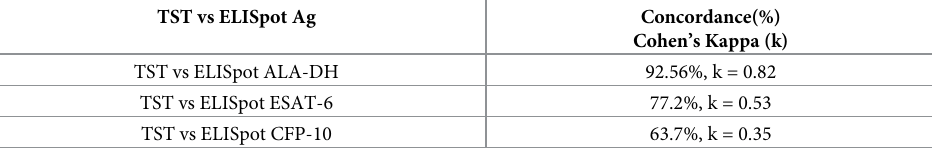
Table 3. Concordance between TST and IL-2 based ELISpot for each antigen in the study, for all the enrolled